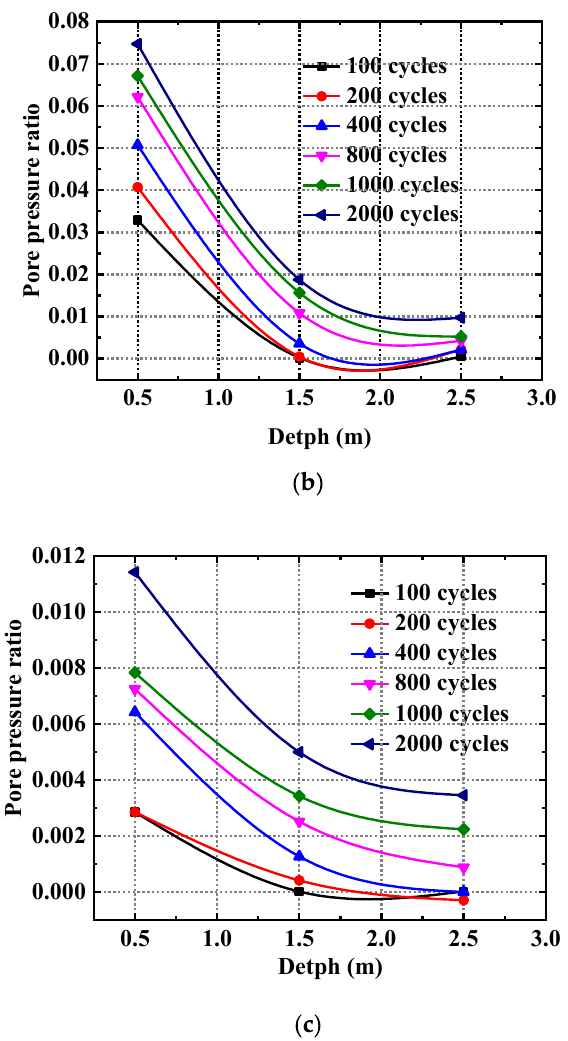
Figure 14. Variation of pore-pressure ratio under different loads. ( a ) Axle load = 240 kN; ( b ) Axle load = 130 kN; ( c ) Axle load = 50